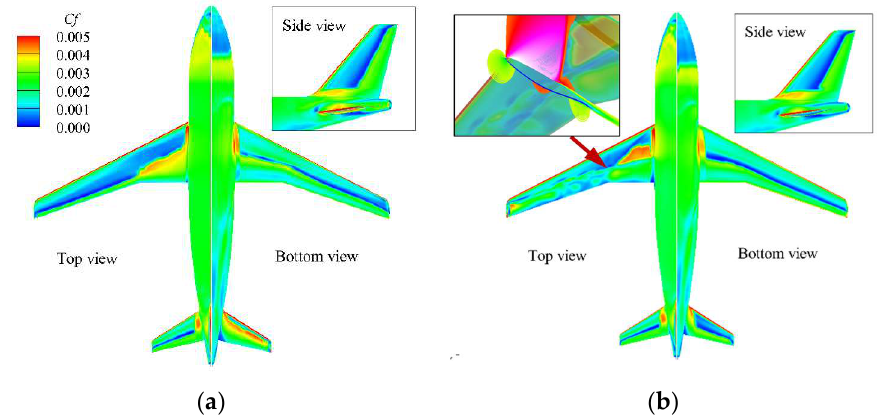
Figure 4. Distribution of surface friction coefficient by CFD. ( a ) α = 0°; ( b ) α = 4°.